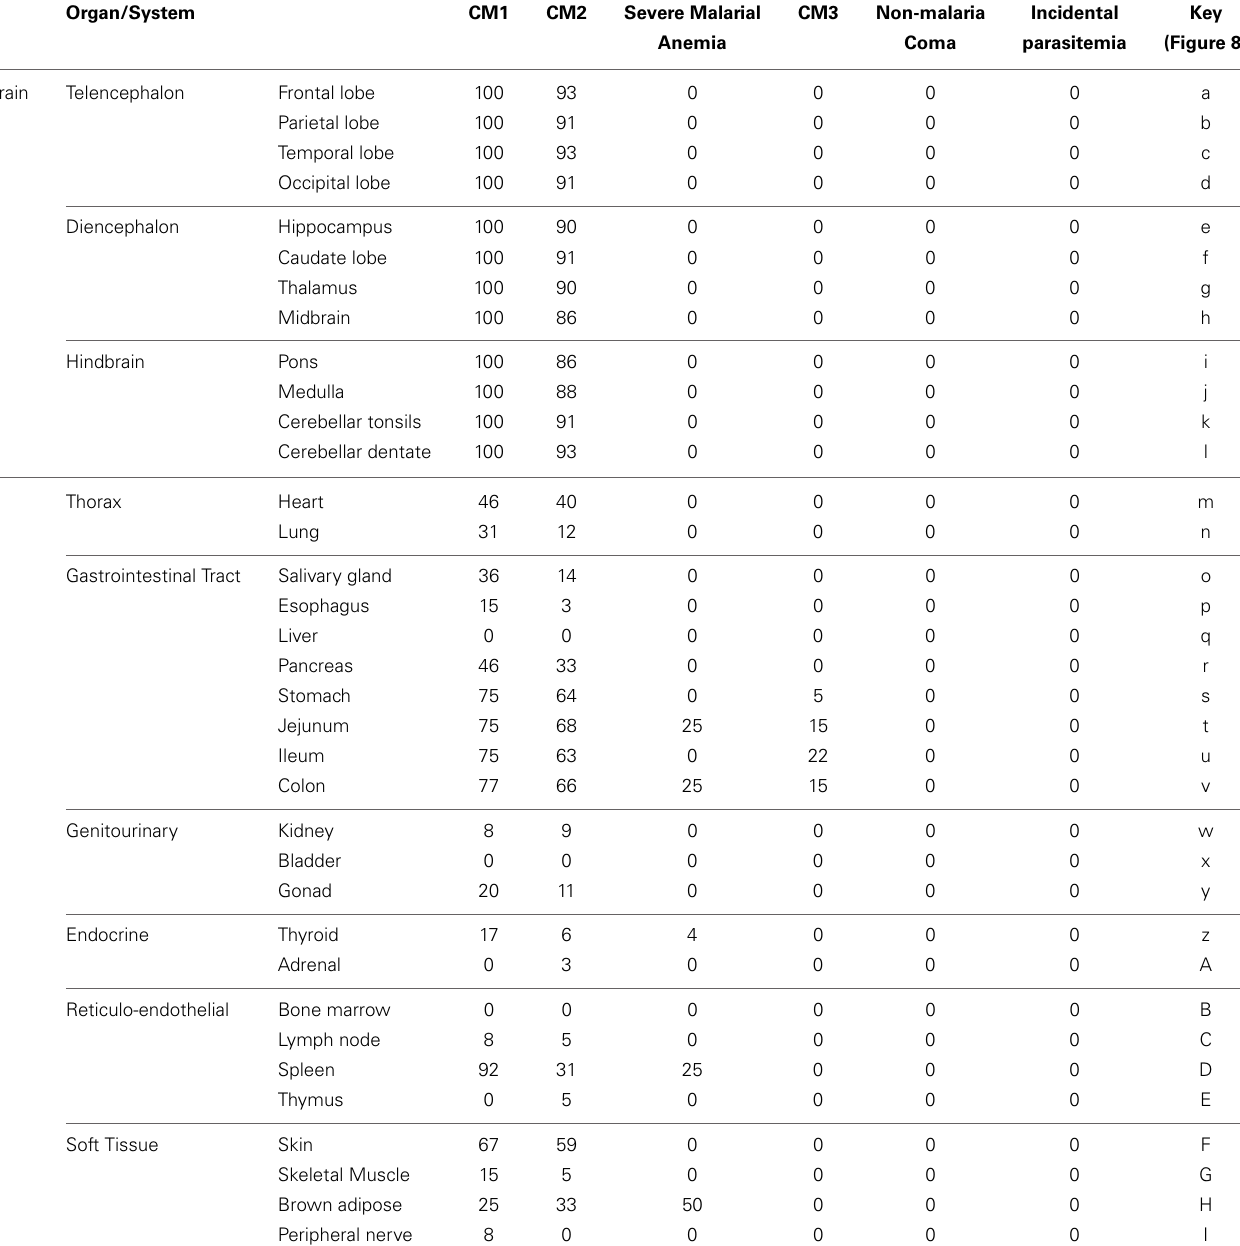
Table 2 | The qualitative totals for absent/present sequestration (%) by organ system and by individual organ across the diagnostic categories are